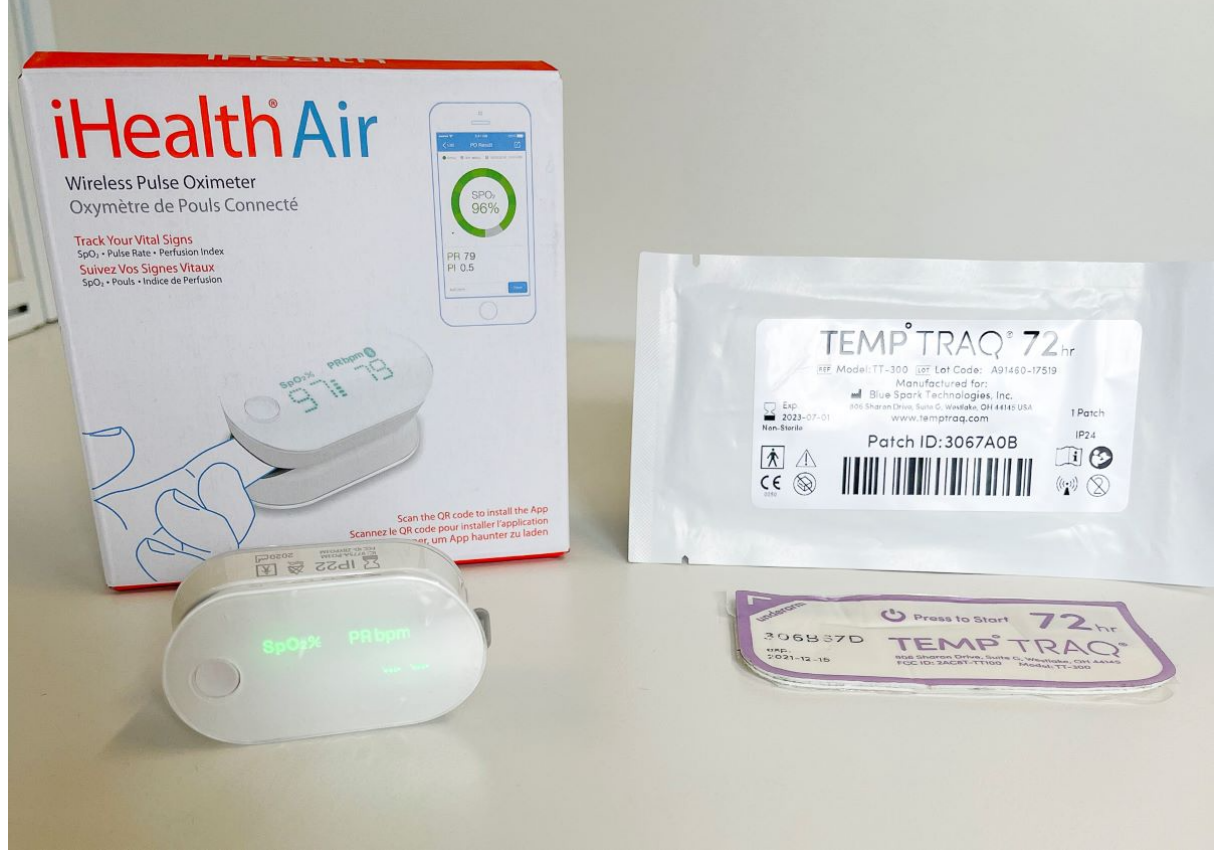
A wireless pulse oximeter (iHealth Air pulse oximeter PO3M, self-applied in the axilla and facilitated continuous temperature monitoring. The device fed data continuously into a web-based dashboard, providing the care center with an overview of all patients. Each patch lasted 72 hours, and each patient was provided with 3 patches to cover the first 9-11 days of